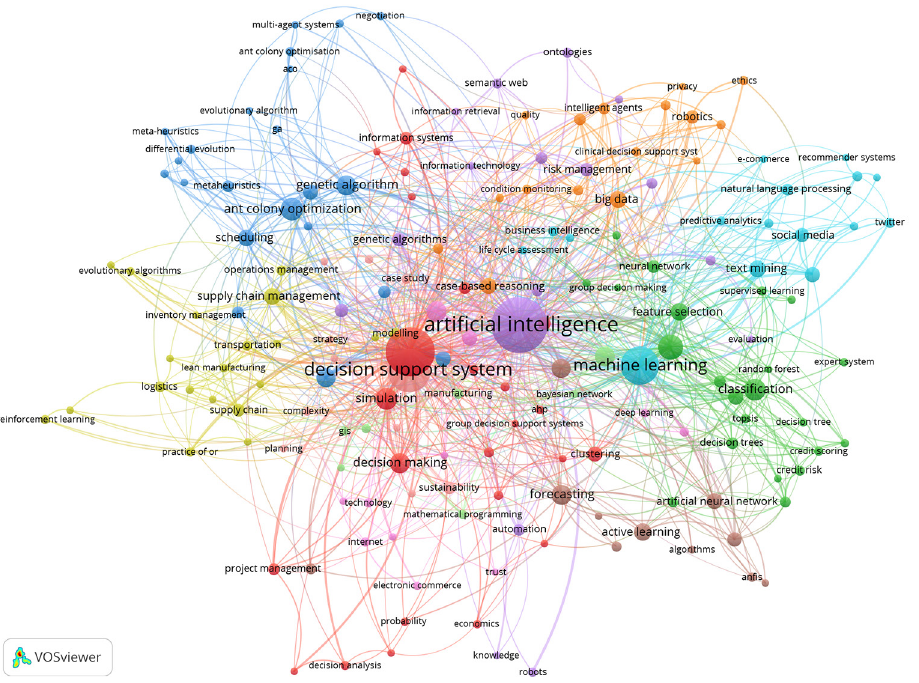
Figure 1. WOS co-occurrence author’s keywords